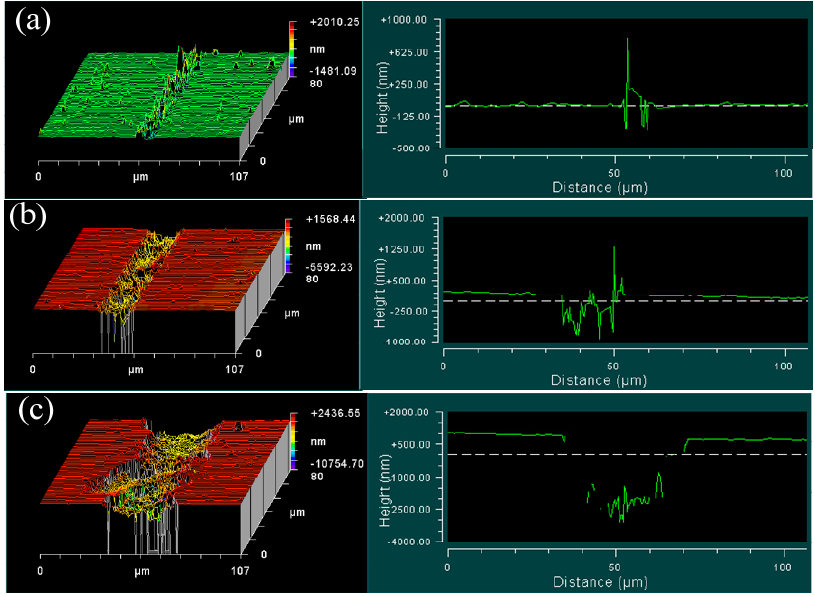
Figure 7. 3D surface morphology and cross-section of cutting groove for fused silica: ( a ) 30 nm; ( b ) 307 nm; ( c ) 2895 nm.